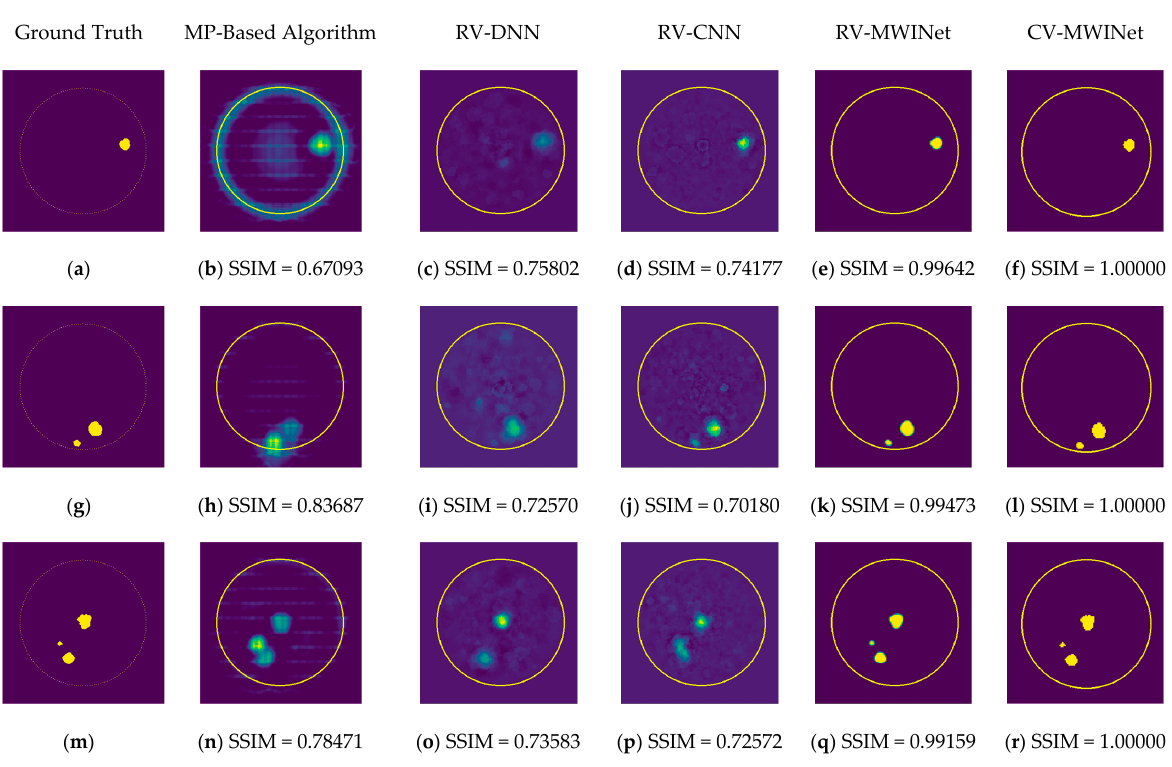
Figure 12. Comparison of samples of microwave images generated by the proposed neurocomputa- tional models for test data (( a , g , m ) are ground truth images).